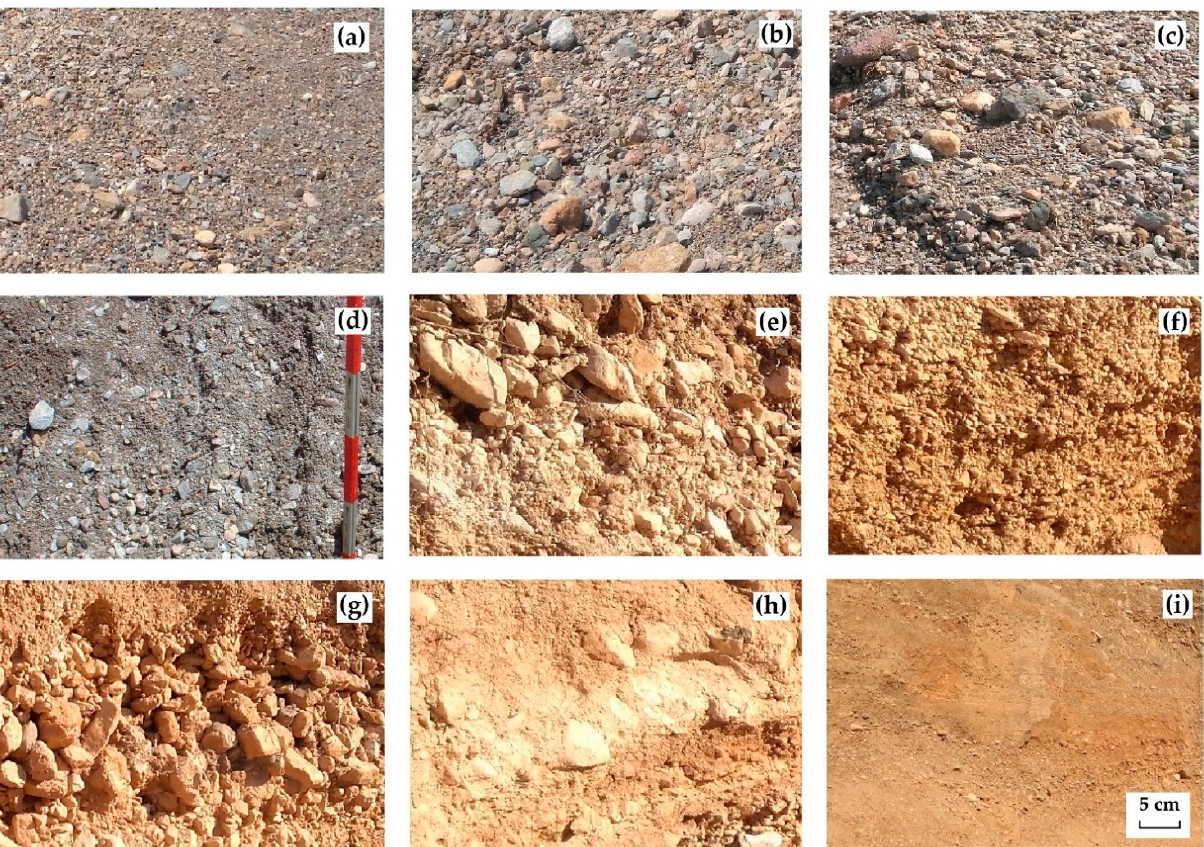
Figure 2. Sediment texture observed on the surface (( a ): active channel, ( b ): transition area between active channel and central alluvial bar, ( c ): central bar platform) and in the depth of the trench sections (( d ): sub-surface layer 1 m deep in the active channel area, ( e – h ): sub-surface layers 1–1.5 m thick from top to bottom in a bar sedimentary sequence), and ( i ): representative texture of the alluvial fan body cut by the Rambla de la Azohía in its upper reach.